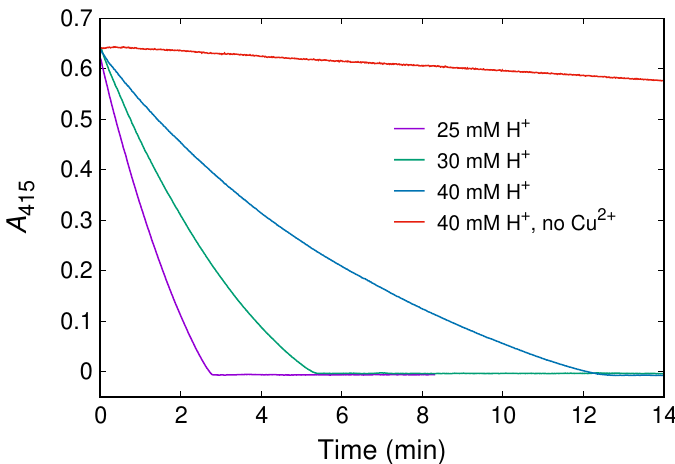
Figure 1. Kinetics of ABTSr decay at 415 nm during the reaction with NAC in the presence of Cu 2+ at [H + ] = 25, 30, and 40 mM. Other initial concentrations (in order of addition): 300 µ M Cu 2+ , 20 µ M ABTSr, 300 µ M NAC. The records were acquired on the diode array spectrophotometer with an open (off) shutter at 20 ◦